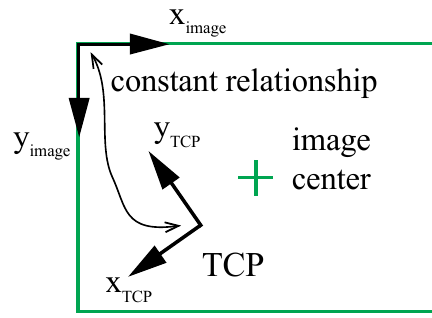
Fig. 4: Relationship between the image and TCP coordinate system. 2 Figure 4. Relationship between the image and TCP coordinate sys- tem.